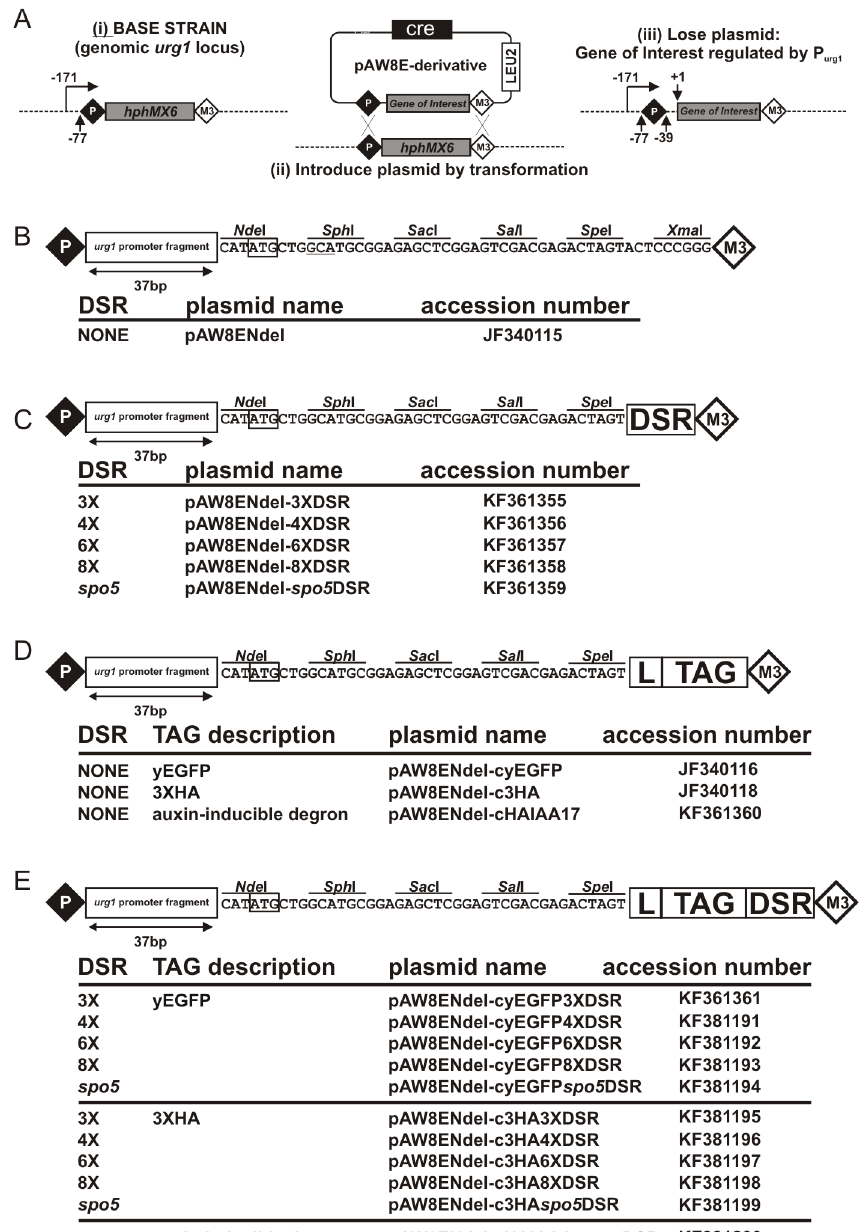
Figure 1. Principals of RCME and plasmids created. ( A ). Schematic showing the process of RCME (Watson 2008): (i) starting with a base strain in which the urg1 ORF is replaced by an antibiotic marker (each of hphMX6 , natMX6 and kanMX6 are available) that is flanked by (incompatible) loxP and loxM3 sites, a plasmid (ii) is introduced. This plasmid contains the cloned gene of interest and any tagging sequences positioned between loxP and loxM3 sites. It also expresses Cre recombinase. Site-directed recombination next exchanges the sequences between the plasmid and the chromosome (iii). Successful exchange can easily be identified by loss of the antibiotic marker, typically seen in greater than 50% of cells. Plasmid loss in these colonies is then confirmed by replica plating to verify colonies are leu 2 . In our experience, all of these are successful integrants. ( B ). Plasmid for expression of untagged sequences (NO DSR) as previously published [7]. Shown is a schematic of the sequence between loxP (P) and loxM3 (M3) for pAW8E Nde I. A start codon is formed from an Nde I site. ( C ) Equivalent schematic of pAW8E Nde I containing various DSR sequences. ( D ) Schematic of plasmid used to express proteins with either a yEGFP tag, a 3xHA tag or an HA combined with an IAA17 degron tag (HAIAA17) (all with NO DSR). L = poly-tyrosine–glycine–serine (TGS) linker: TAG = yEGFP, 3xHA or HAIAA17 protein tag. ( E ) Equivalent schematic of pAW8E Nde I C-terminal tagging plasmids that also contain various DSR sequences. HA = human influenza hemagglutinin protein tag, yEGFP = yeast codon optimised green fluorescent protein, HAIAA17 = Degron from Arabidopsis thaliana transcription